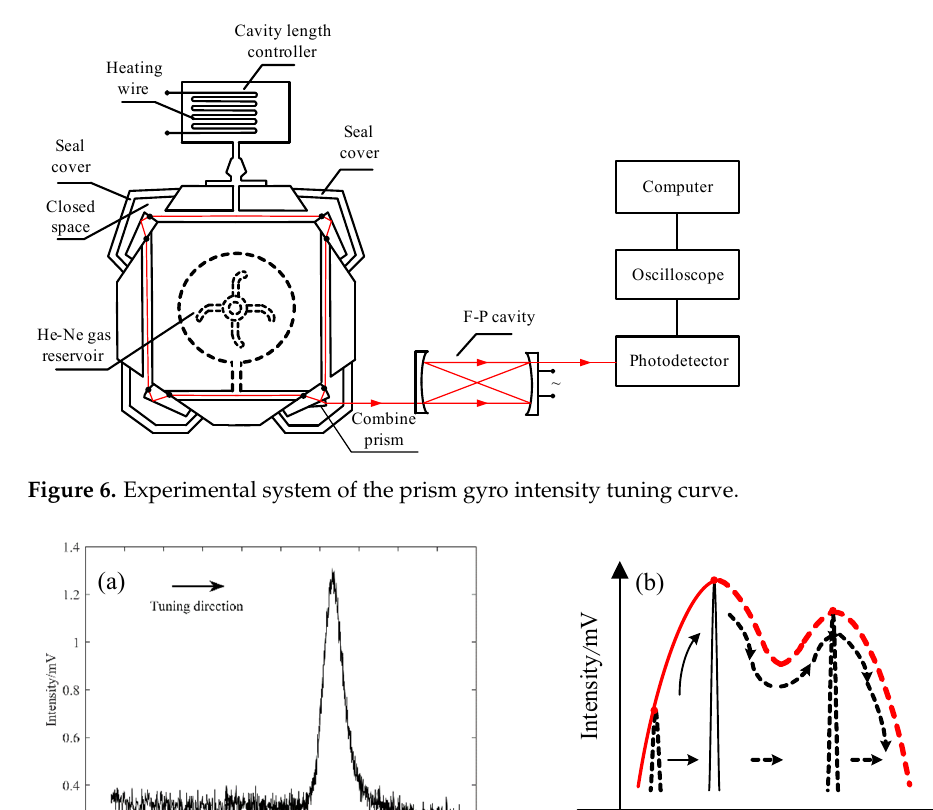
Figure 7. Profile of the intensity tuning curve obtained by the F ‐ P cavity. ( a ) Frequency diagram of the longitudinal mode; ( b ) schematic of the profile detection of the intensity tuning curve.